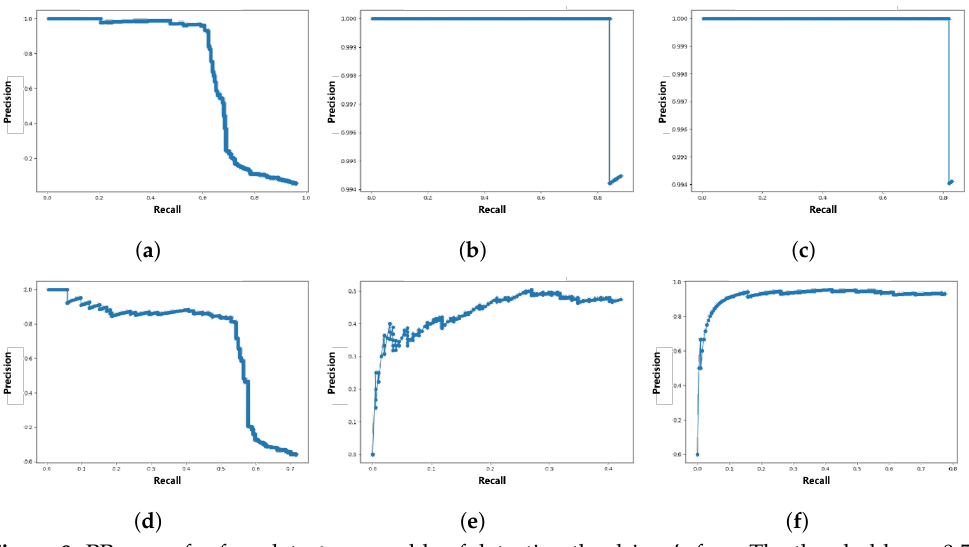
Figure 9. PR curve for face detectors capable of detecting the driver’s face. The thresholds are 0.5 and 0.75. ( a ) OpenCV, threshold is 0.5; ( b ) MMOD, threshold is 0.5; ( c ) MTCNN, threshold is 0.5; ( d ) OpenCV, threshold is 0.75; ( e ) MMOD, threshold is 0.75; ( f ) MTCNN, threshold is 0.75. Table 5. Driver’s face detection performance comparison of face